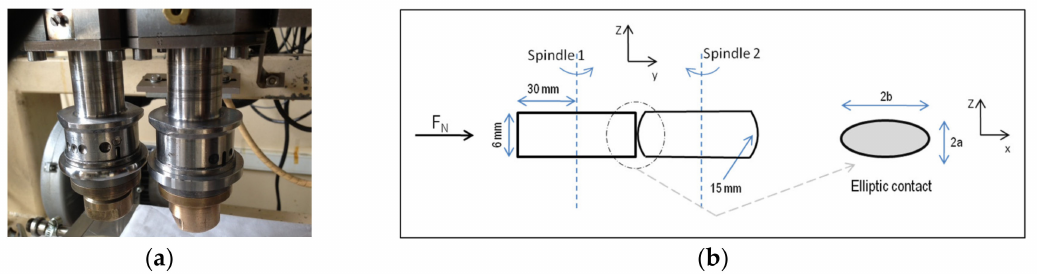
Figure 1. ( a ) The twin-disk tribometer and ( b ) the elliptic contact between both test